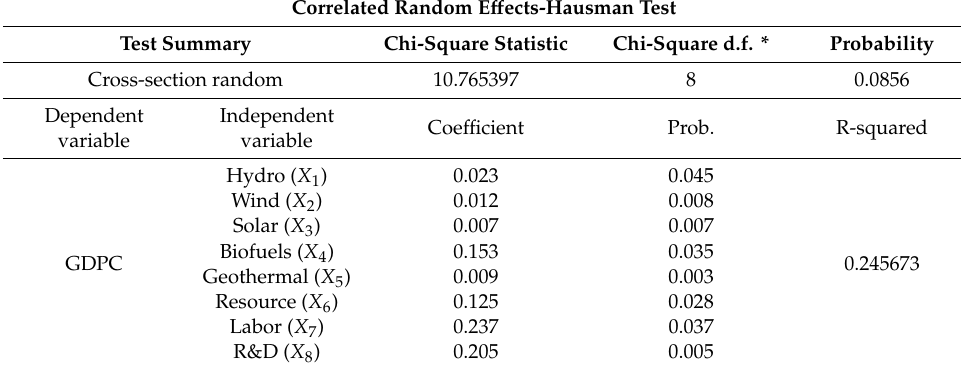
Table 9. Impact of hydro energy, wind energy, solar energy, bioenergy production, geothermal energy, resource productivity, labor force, and R&D development in economic growth, at the EU